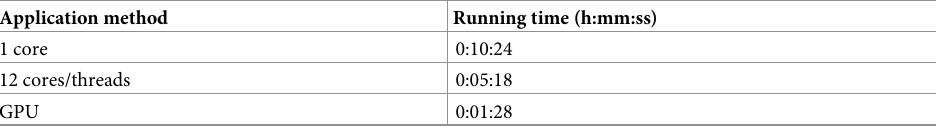
Table 4. Multiprocessing and GPU application of SVMs significantly reduces run-times. Application